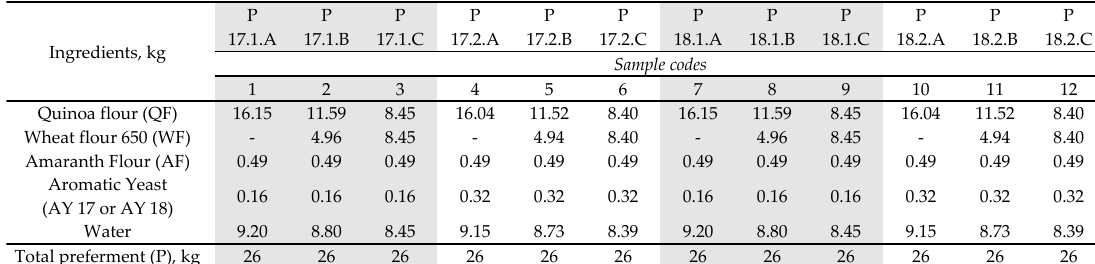
Table 1. Proportion of ingredients for the total amount of preferment used in 100 kg dough manufacturing.